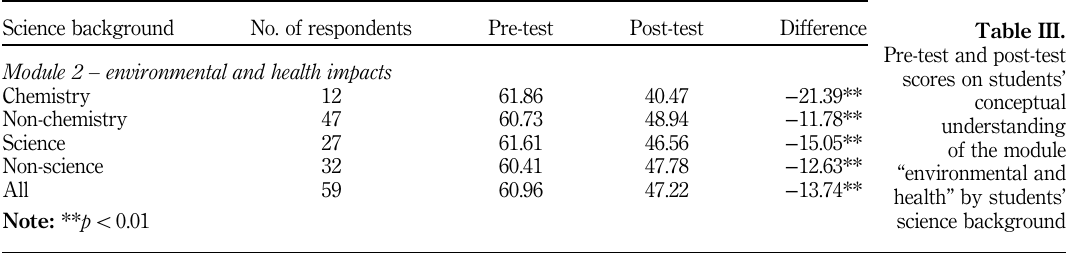
Table III. Pre-test and